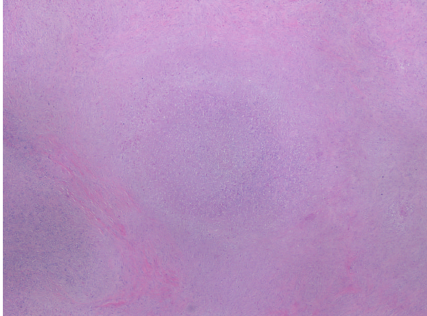
Figure 5: Microscopy 4x magnification: Hematoxylin and Eosin stain demonstrating confluent necrotizing granulomas with periph- eral bands of sclerosis.